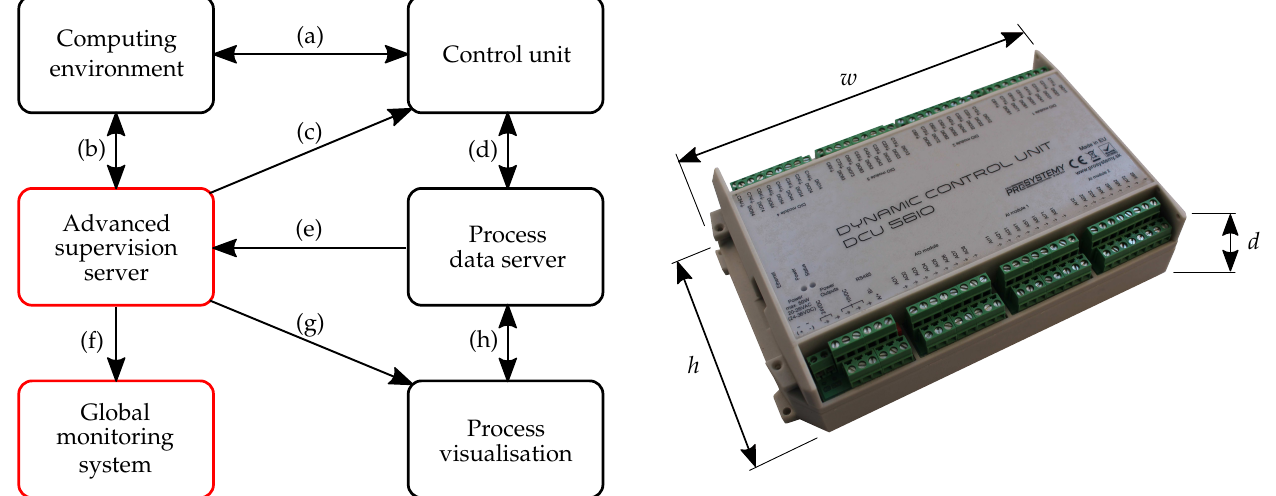
Figure 1. Simplified schematic of the GMCS structure (left) with the control unit DCU56IO depicted (right). (a)–(h) – communication channels, w 138 53.5mm – physical dimensions of the control unit. h d = 230.2 × × × ×